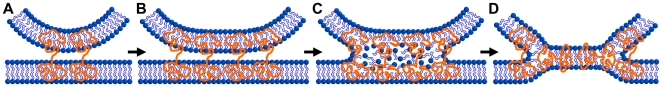
Proposed of model of how a denatured protein can induce membrane hemifusion without proceeding through a stalk intermediate.The model postulates that denatured proteins (represented as orange randomly shaped curves), and perhaps other amphpathic macromolecules, can induce hemifusion by binding to two membranes (A), accumulating at the membrane-membrane interface (B), and causing a scrambling of lipid molecules at the interface (C) that eventually rearranges into a stable hemifusion diaphragm (D). A curved membrane from a vesicle and a flat membrane are used in the drawings, but the mechanism could apply to membranes with diverse curvatures.